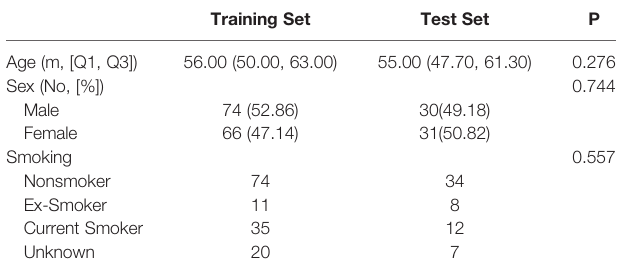
TABLE 1 | Demographic data of training set and test